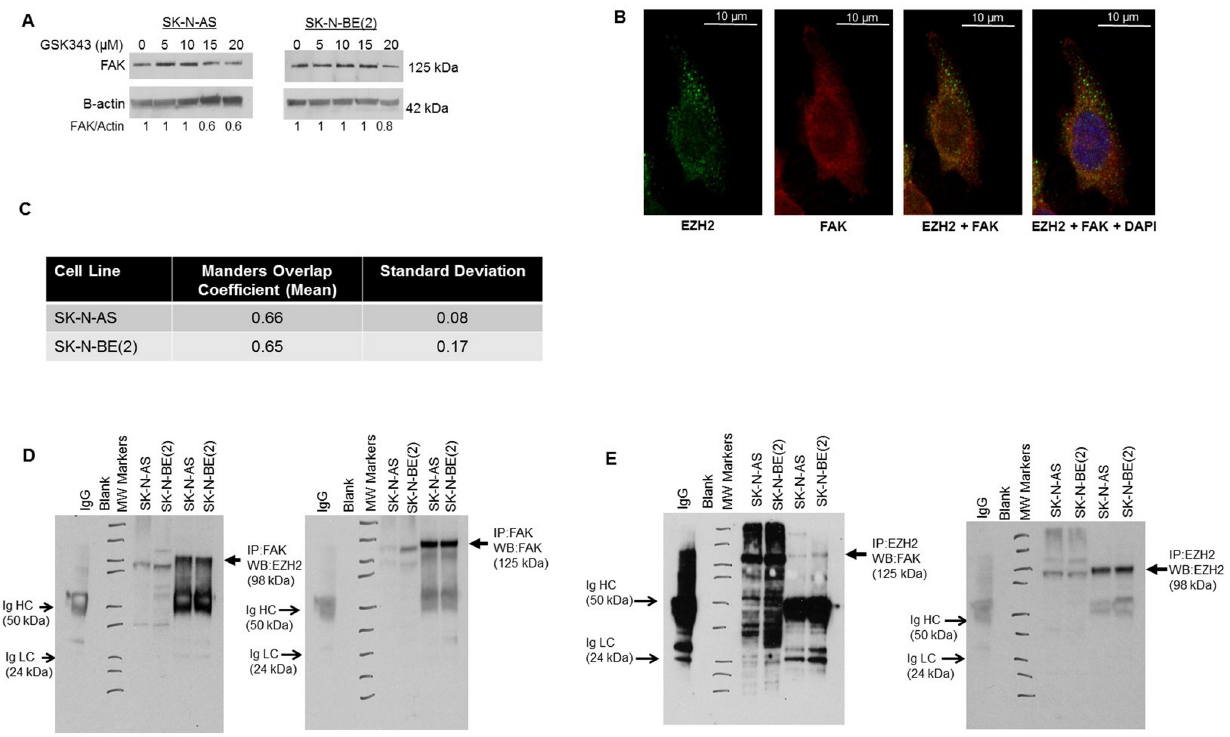
Fig 6. EZH2 and FAK association in neuroblastoma. (A) SK-N-AS and SK-N-BE(2) cells were treated with increasing doses of GSK343 for 24 hours. Whole cell lysates were examined with immunoblotting. There was a dose dependent decrease in FAK expression. (B) Immunofluorescence staining followed by confocal microscopy was utilized to investigate EZH2 and FAK interaction in SK-N-AS and SK-N-BE(2) cell lines. Representative photographs of SK-N-AS cells are presented. There was an overlap in staining between EZH2 (green, first panel ) and FAK (red, second panel ), depicted as yellow color ( third panel ), indicating an interaction. DAPI staining was completed to identify the nucleus ( fourth panel ). White scale bars represent 10 μ m. (C) To quantitate overlap, Manders overlap coefficients were calculated for SK-N-AS (0.66) and SK-N-BE(2) (0.65) cells. These values were greater than 0, providing evidence of an interaction between EZH2 and FAK. (D) Immunoprecipitation with FAK followed by Western blotting for EZH2 was used to demonstrate an interaction between FAK and EZH2 ( lanes 6 , 7 , closed arrows ). (E) The reverse, immunoprecipitation for EZH2 followed by Western blotting for FAK revealed an interaction between EZH2 and FAK ( lanes 6 , 7 , closed arrows ). IgG served as a control. IgG heavy chain (HC) and light chain (LC) bands are indicated on the blots ( open arrows ). Whole cell lysates without IP were included on each of the blots ( lanes 4 , 5